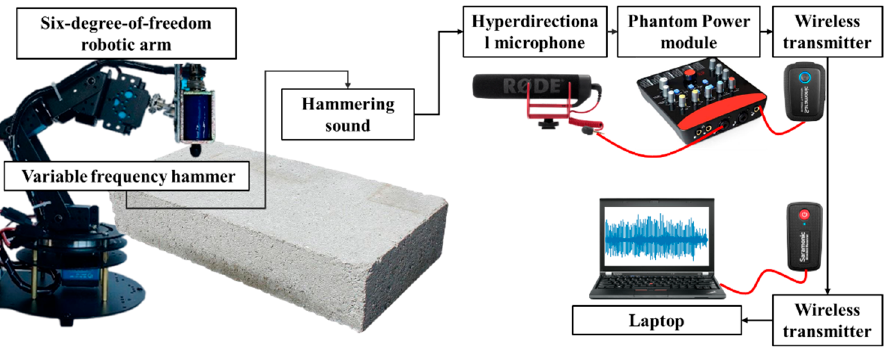
Figure 6. Schematic of the experimental setup.